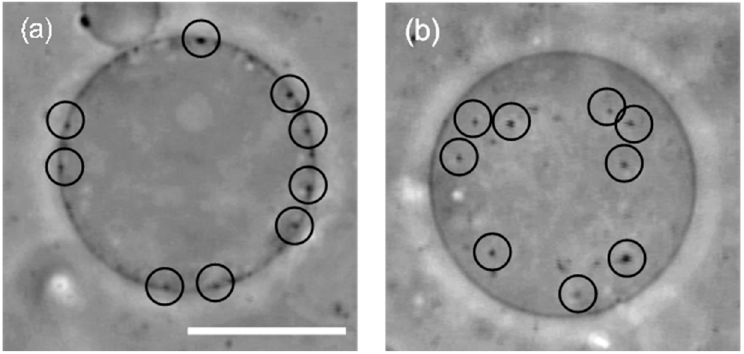
Figure 1. ( a ) A liposome with 200 nm fully wrapped particles before the application of osmotic pressure. Black circles show the position of fully wrapped particles; ( b ) Penetration of particles after the application of osmotic pressure. Scale bar is 10 µm.